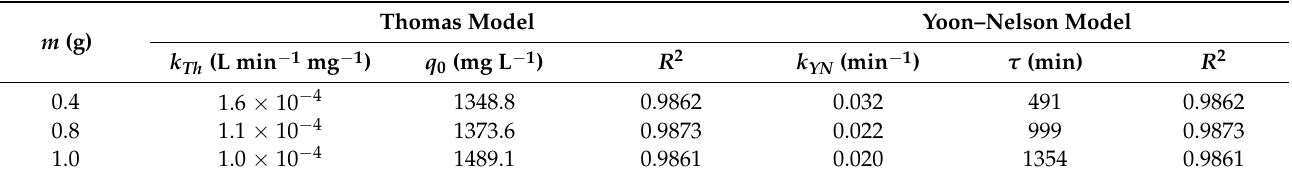
Table 6. Parameters of the nonlinear Thomas and Yoon–Nelsons